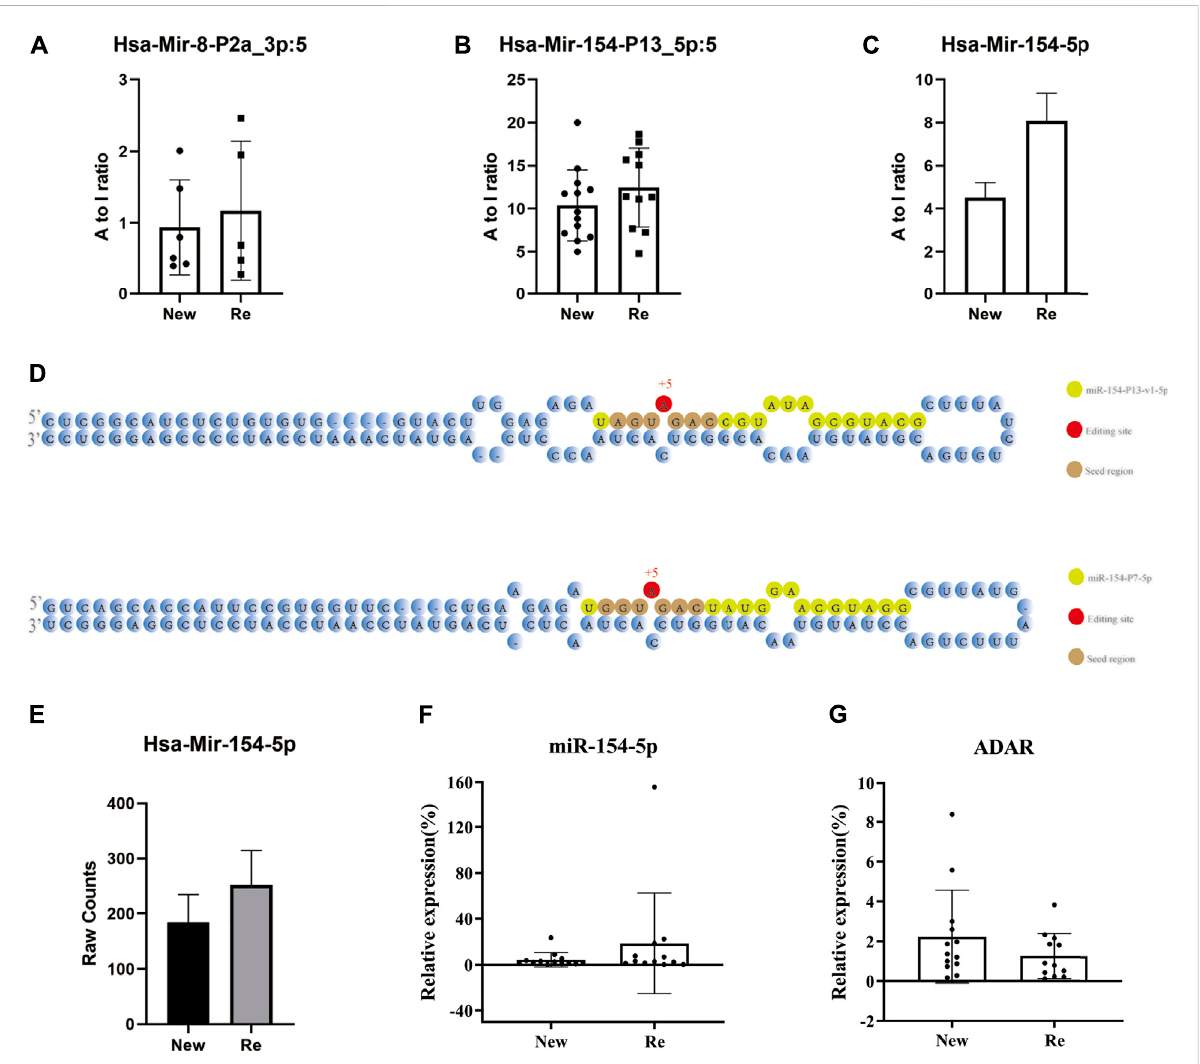
FIGURE 4 Overview of miRNA editing events of 12 recurrent tumors vs. 13 primary tumors. (A – C) Bar plots showing miRNA editing A-to-I ratio levels of three different miRNAs in both primary and recurrent tumors, with hyper edited in recurrent BC ( p -value < 0.05). Hsa-Mir-154-5p exhibited the most signi fi cantdifference.*: p -value < 0.05. (D) Identi fi cationofeditedmaturemiR-154.The5 ′ endofthematuremiRNAiscountedas+1,andtheediting siteisindicatedbythenumberhighlightedinred.Theseedregionischaracterisedbyhighlightedinbrown. (E) ABarplotshowingtherawcount level of mir-154-5p in both primary and recurrent tumors. (F , G) RT-qPCR result for miR-154-5p and ADAR. In recurrent tumors, miR-154-5p expression levels were slightly upregulated ( p -value = 0.2567), while ADAR expression levels were downregulated ( p -value =